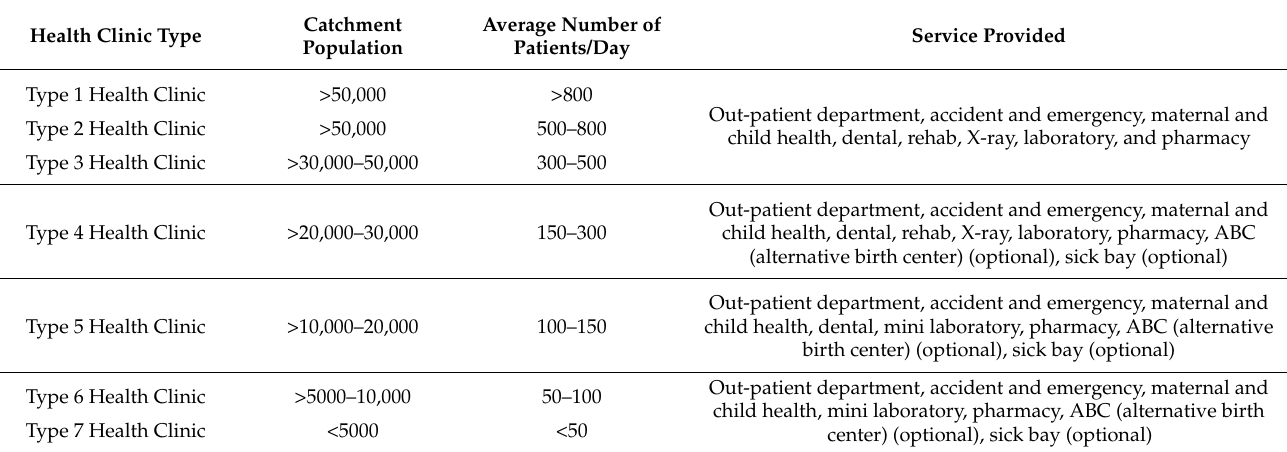
Table 1. Primary health clinic types in